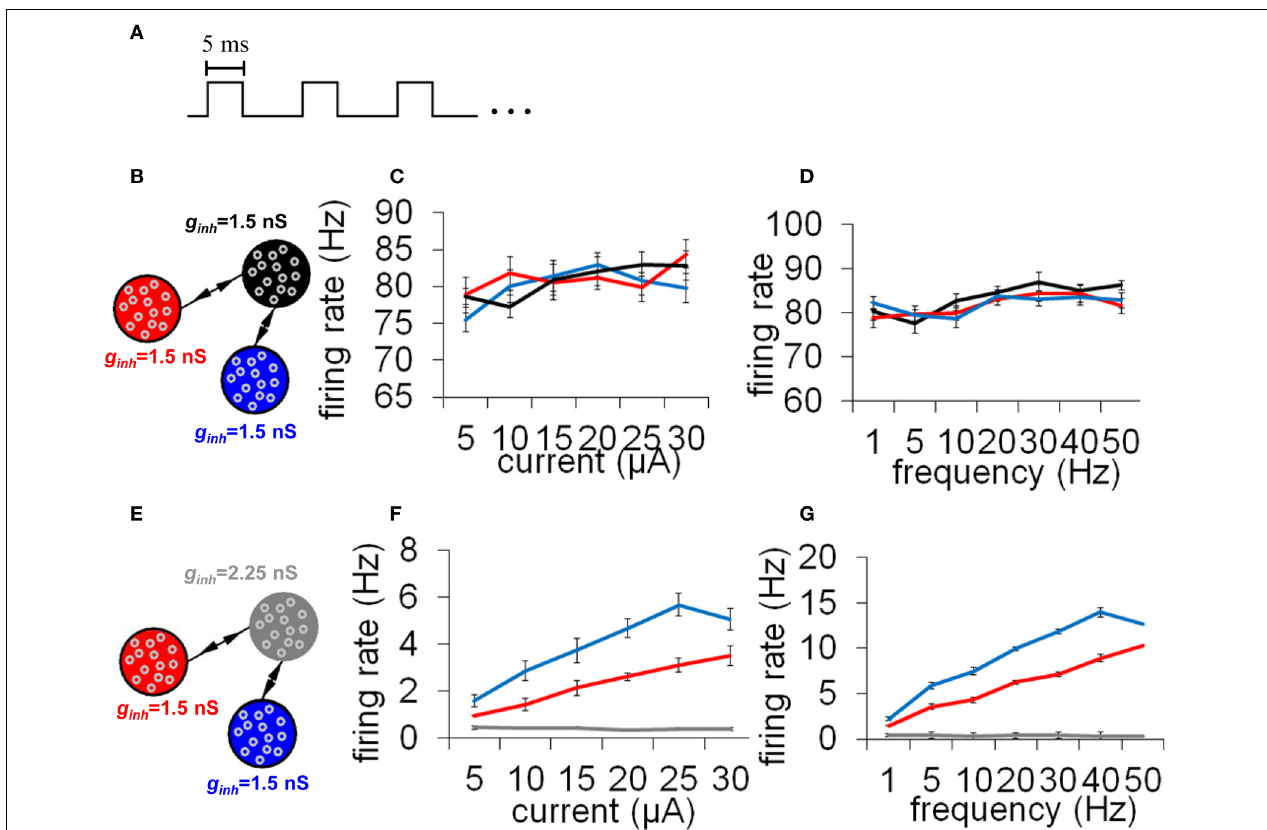
relay network. We monitored mean firing rates within each population of neurons in response to different current intensities (C) and stimulus frequencies (D) . (E) Network where one subpopulation of neurons (the “relay neurons”) had gain inhibition set to g inh = 2 . 25nS (a 50% increase from the default value). (F,G) Responses to external stimuli in a relay network with increased gain inhibition as shown in (E) . All simulations were run for a total of 30s of activity. Vertical bars =